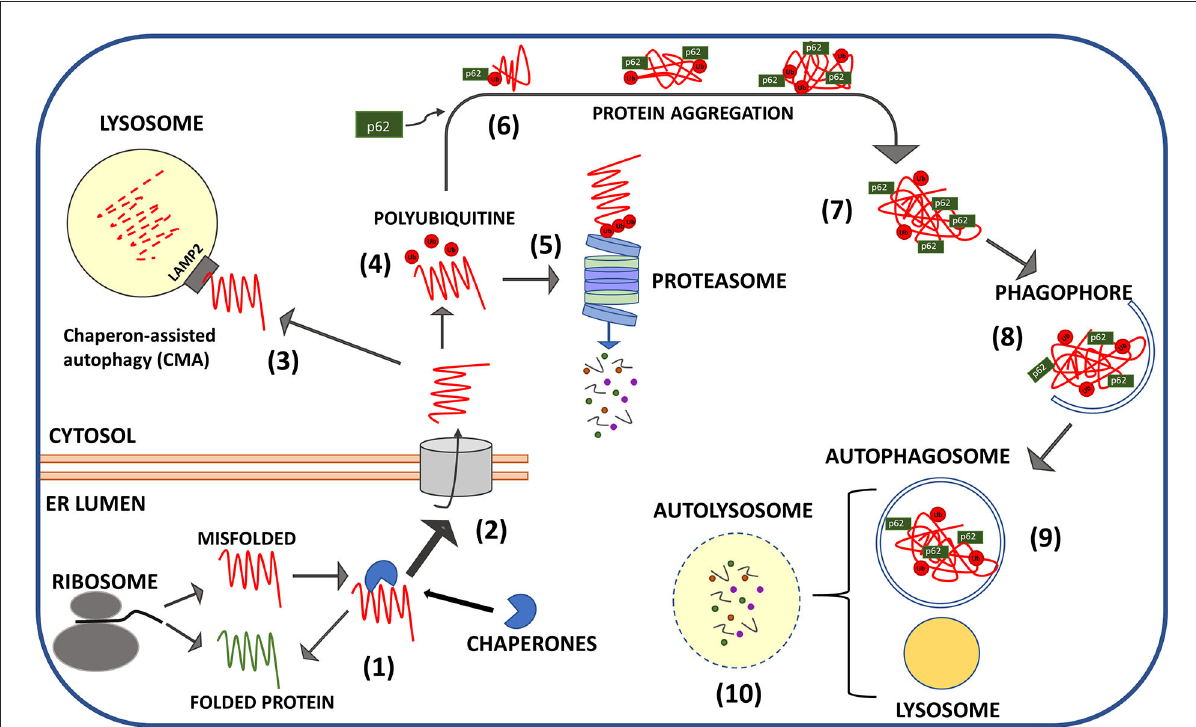
FIGURE2 Schematic representation of protein quality control mechanisms of misfolded PrP. Structural aberrancy of nascent PrP C (spontaneously occurring or favored by PRNP mutations) is sensed in the ER leading to the recruitment of chaperones that block PrP C in unfolded state until proper folding (1) is restored. Terminally misfolded PrP is translocated in the cytosol (2) for lysosomal chaperone associate autophagy (CMA) (3) or ubiquitination (red dots: ubiquitin moieties) (4) and proteasomal digestion (5). Cytosolic aggregates of ubiquitinylated PrP escape proteasome (6) and are clustered in larger inclusion bodies by the intervention of adaptor proteins mainly p62 (7). P62 drives the aggregates toward the nascent phagophores that engulf PrP clusters in autophagosomes (8). Autophagosomes fusion with lysosomes produces digestion of aggregates (9) and recycling of nutrients